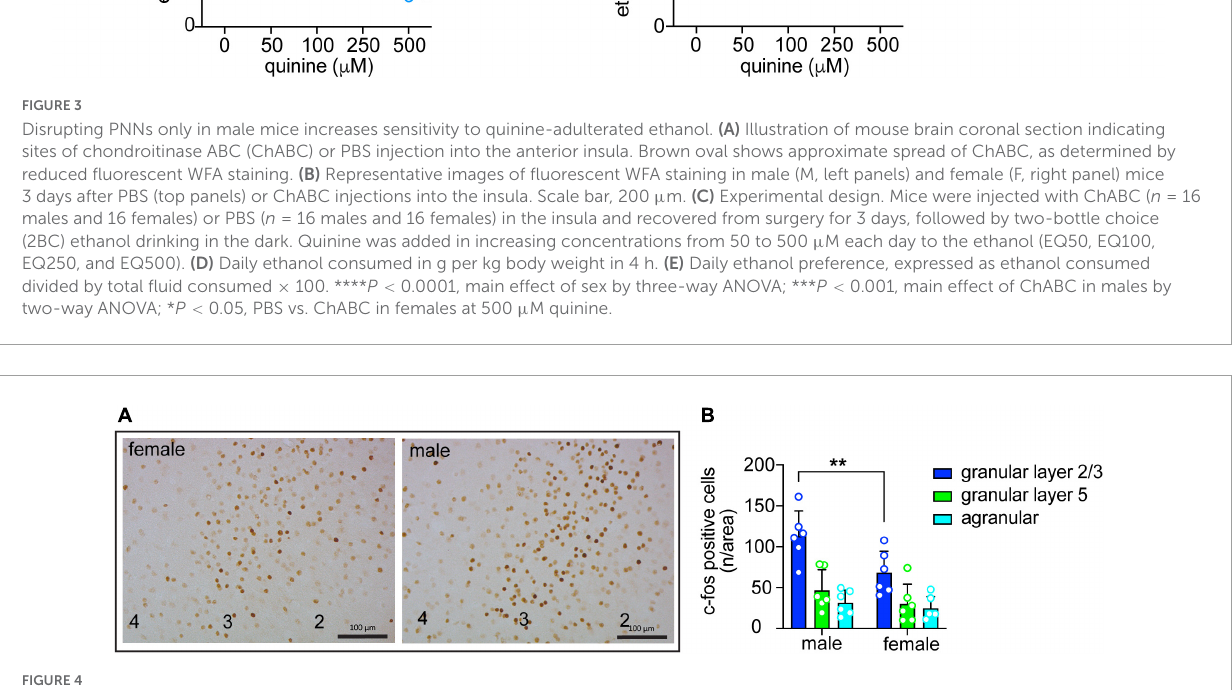
FIGURE4 Sex differences in insula activation during consumption of quinine-adulterated ethanol. (A) Representative images of c-fos immunohistochemistry in the granular layer of the insula of male and female mice after drinking ethanol with 250 µ M quinine. Cortical layers are indicated at the bottom. Scale bars, 100 µ m. (B) Quantification of c-fos immunohistochemistry ( n = 6 males and 6 females) in the granular and agranular layers of the insula of mice after drinking ethanol with 250 µ M quinine. ** P < 0.05, effect of sex in granular layer 2/3 by Bonferroni’s multiple comparisons test after two-way